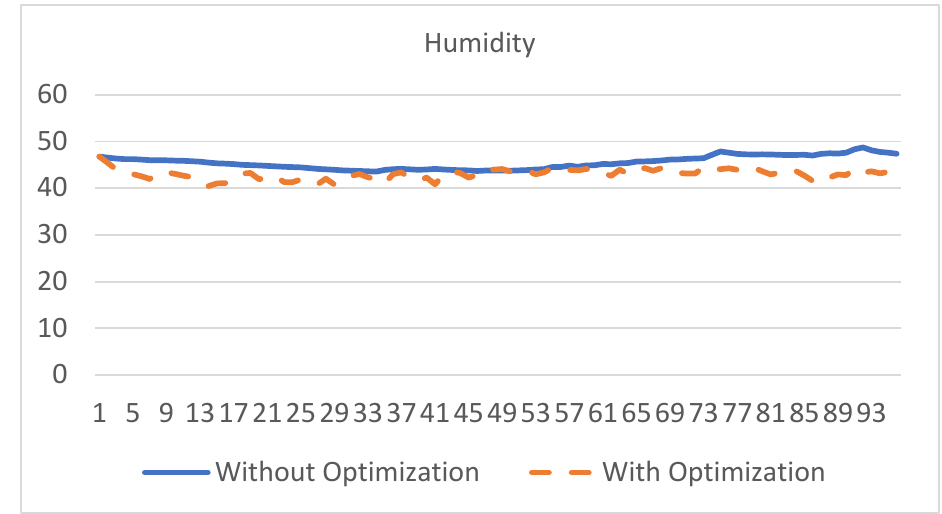
Figure 8. Comparison Results between Current and Optimized Indoor Humidity for Efficient Thermal Comfort Control.